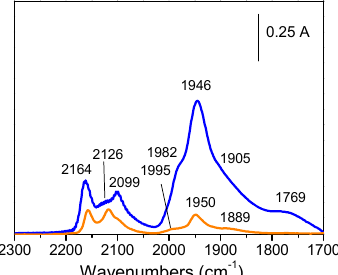
Figure 17. FTIR spectra of CO adsorbed at r.t. on the ZS–PdAu (blue curve) and CeS–PdAu (orange curve) samples previously contacted with a H 2 –O 2 mixture at room temperature. The spectra have been normalized to the same Pd content. Reprinted from J. Catal., 257, F. Menegazzo, P. Burti, M. Signoretto, M. Manzoli, S. Vankova, F. Boccuzzi, F. Pinna, G. Strukul, Effect of the addition of Au in zirconia and ceria supported Pd catalysts for the direct synthesis of hydrogen peroxide, 369–381, Copyright (2008), with permission from